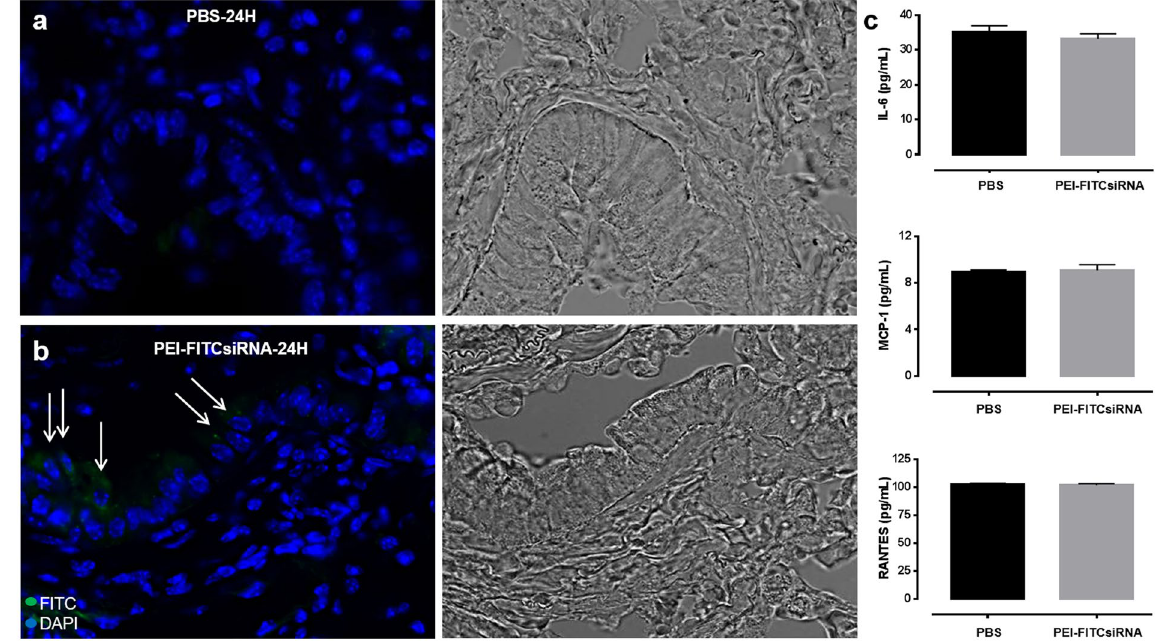
Figure 3. Distribution of PEI-FITCsiRNA nanoplexes in mouse lung following intranasal administration. Representative images of lung sections stained with DAPI ( blue ) to label cell nuclei after 24 hours of intranasal administration of PBS (A, left panel) and PEI-FITCsiRNA (B, left panel). Arrows indicate the presence of green fluorescent signals in the ciliated epithelial cells at 63X magnification. (A,B, right panel) Respective bright field images for morphology confirmation. ( C ) The other half of lung tissues was used to detect the indicated cytokines and chemokines by ELISA. Values were determined from standard curves and are presented as the mean ± the standard error of the mean (S.E.M.) of three independent